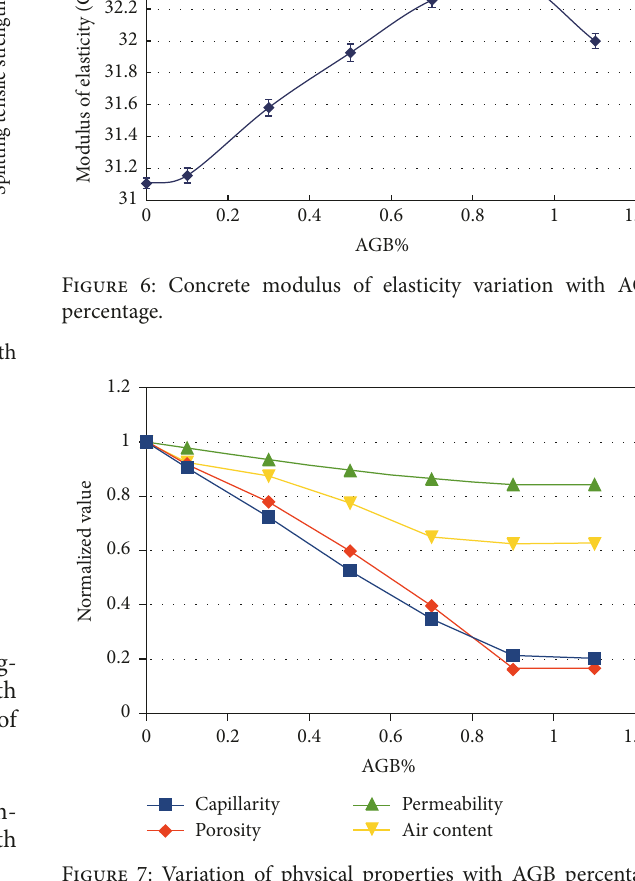
Figure 7: Variation of physical properties with AGB percentage (capillarity, porosity, and air content data